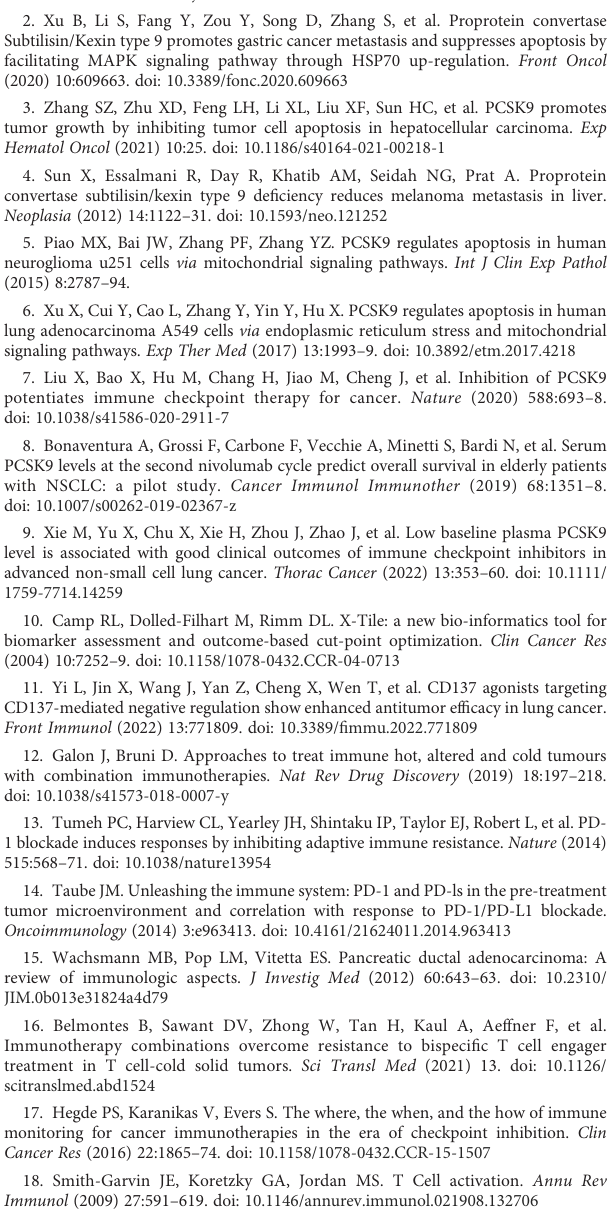
SUPPLEMENTARY FIGURE 1 RelationshipbetweenPCSK9expressioninNSCLCtissuesandclinicopathological characteristics of advanced NSCLC patients. ECOG, Eastern Cooperative Oncology Group. *PD-L1 negative, TPS<1%; PD-L1 low, TPS<50%; PD-L1 high, TPS ≥ 50%.